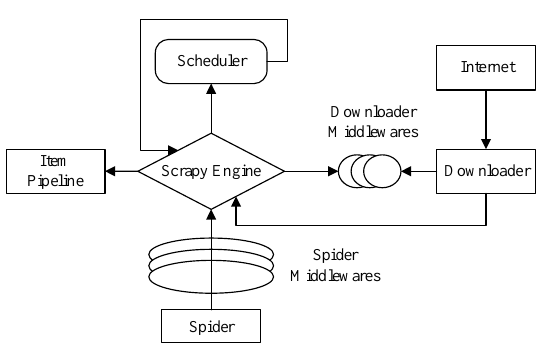
Figure 2. The framework of the crawler.